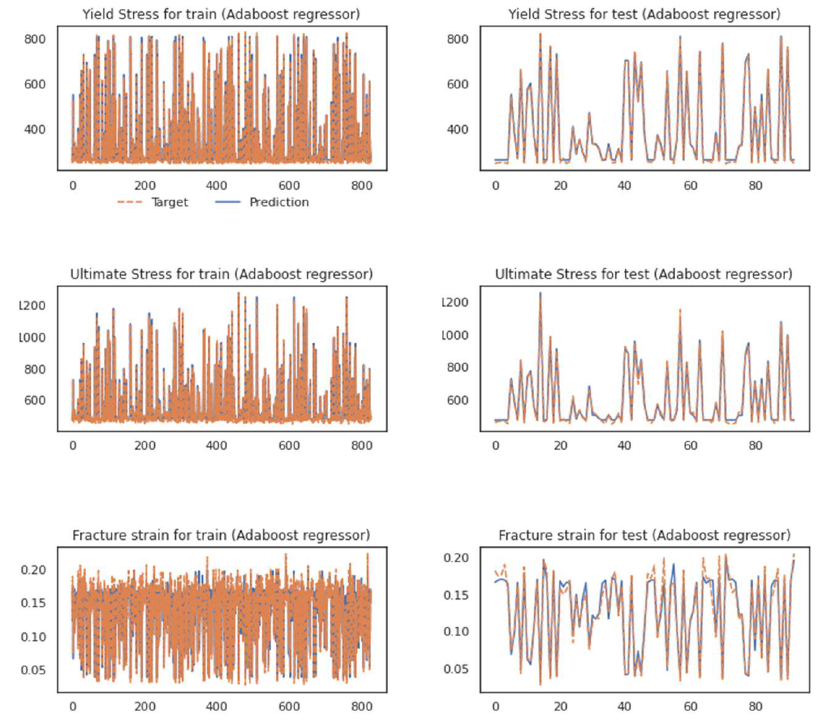
Figure 11. Performance of the proposed hybrid model while using the Adaboost regressor.